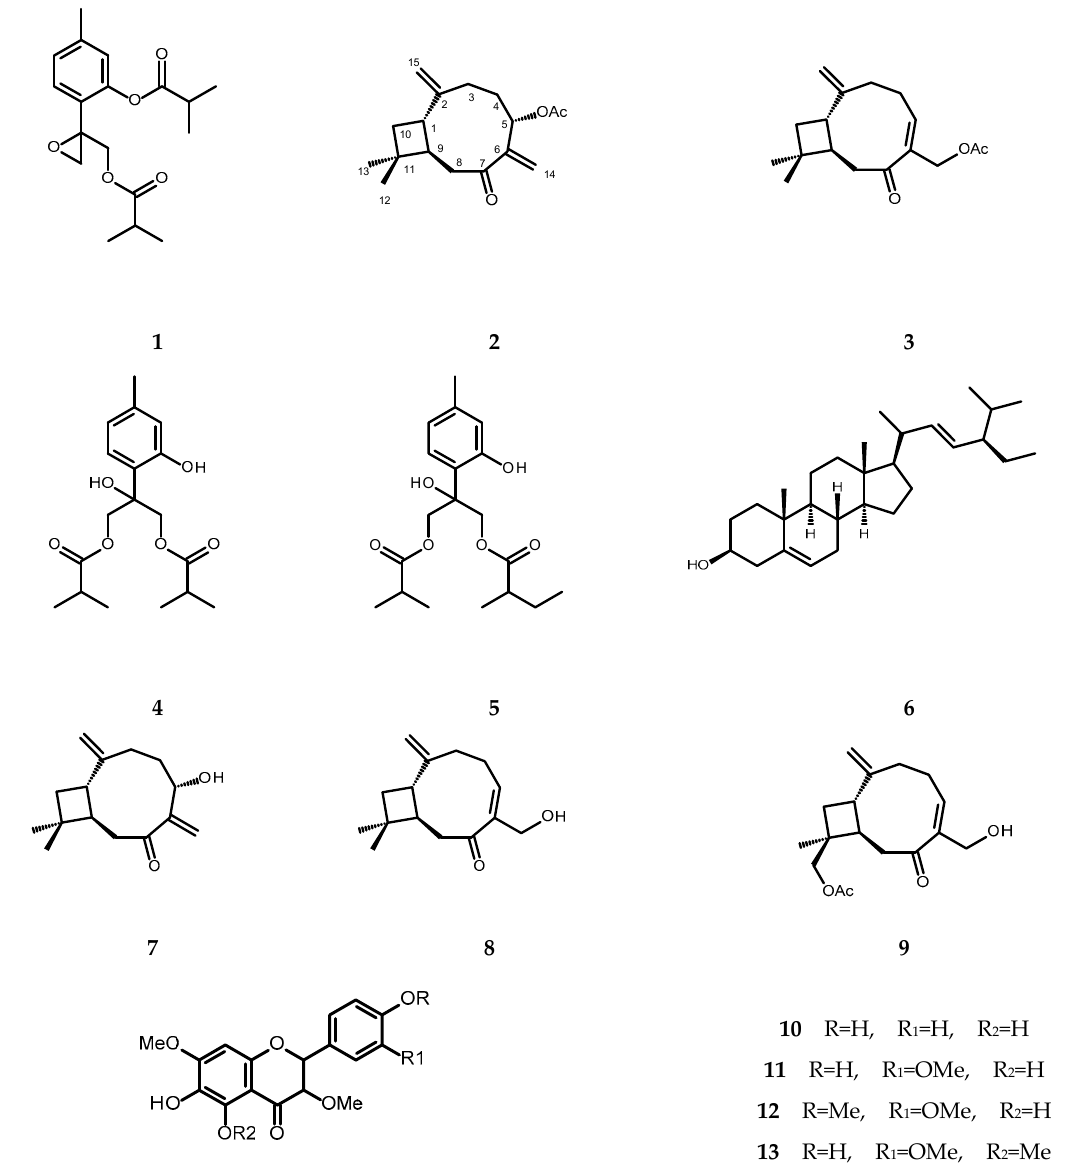
Figure 2. Chemical structures of terpenoid compounds isolated from the chloroform extract of Puli-